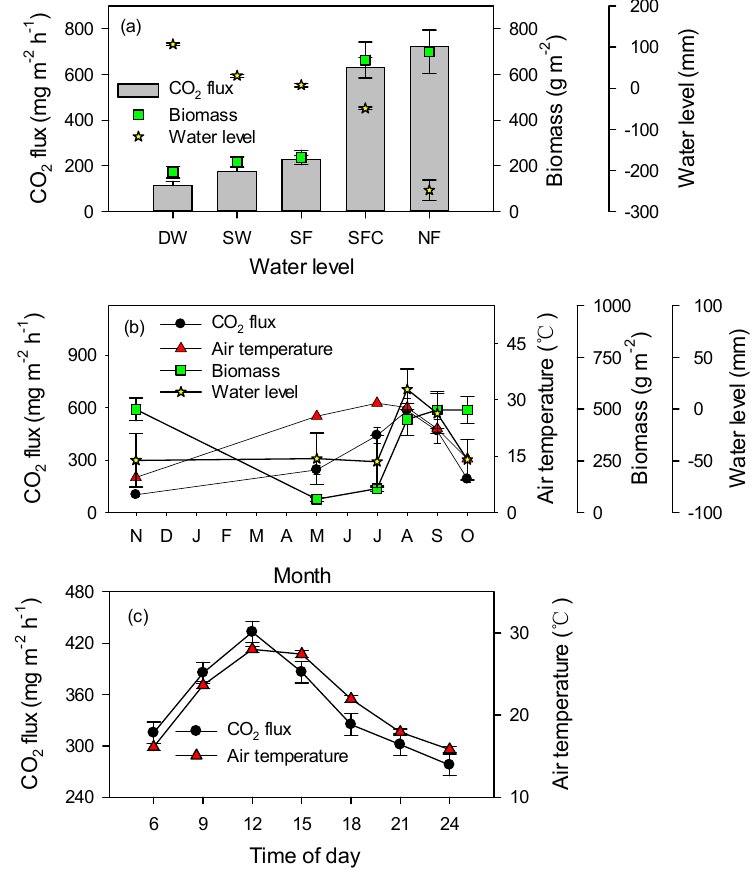
Figure 2. Spatiotemporal variation of CO 2 flux and environments (mean ± SE). ( a ) CO 2 flux, biomass and water level of each area. Linear regressions: Flux CO2 = 1.07 × Biomass − 51.7, n = 5, p < 0.01, r 2 = 0.99; Flux CO2 = − 0.43 × Water level + 129.2, n = 5, p = 0.04, r 2 = 0.80. ( b ) CO 2 flux, temperature, biomass and water level of each month. Linear regressions: Flux CO2 = 19.43 × Temperature − 80.9, n = 6, p = 0.05, r 2 = 0.66; Flux CO2 = 484.9 × Water level + 4.9, n = 6, p = 0.06, r 2 = 0.63; regression with biomass was not significant, p = 0.92. ( c ) CO 2 flux and temperature of each time of day. Linear regression: Flux CO2 = 10.18 × Temperature + 126.8, n = 7, p < 0.01, r 2 = 0.86. DW: deep water site; SW: shallow water site; SF: seasonally flooded site; SFC: ’control site’ for the seasonally flooded site; NF: non-flooded site. Some error bars are invisible because they are too small to see.